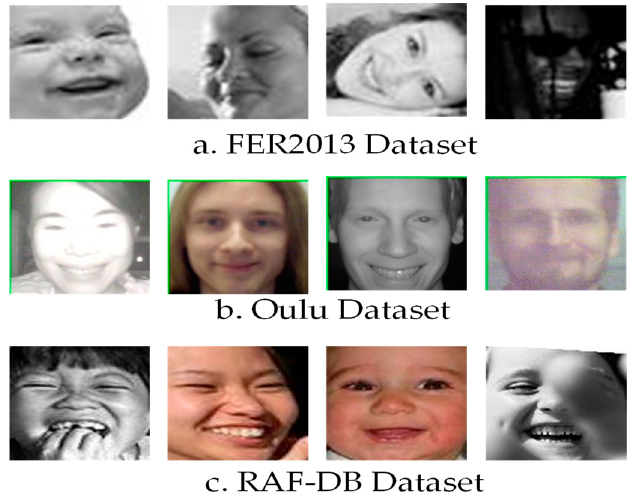
Figure 8. Partial dataset image display.